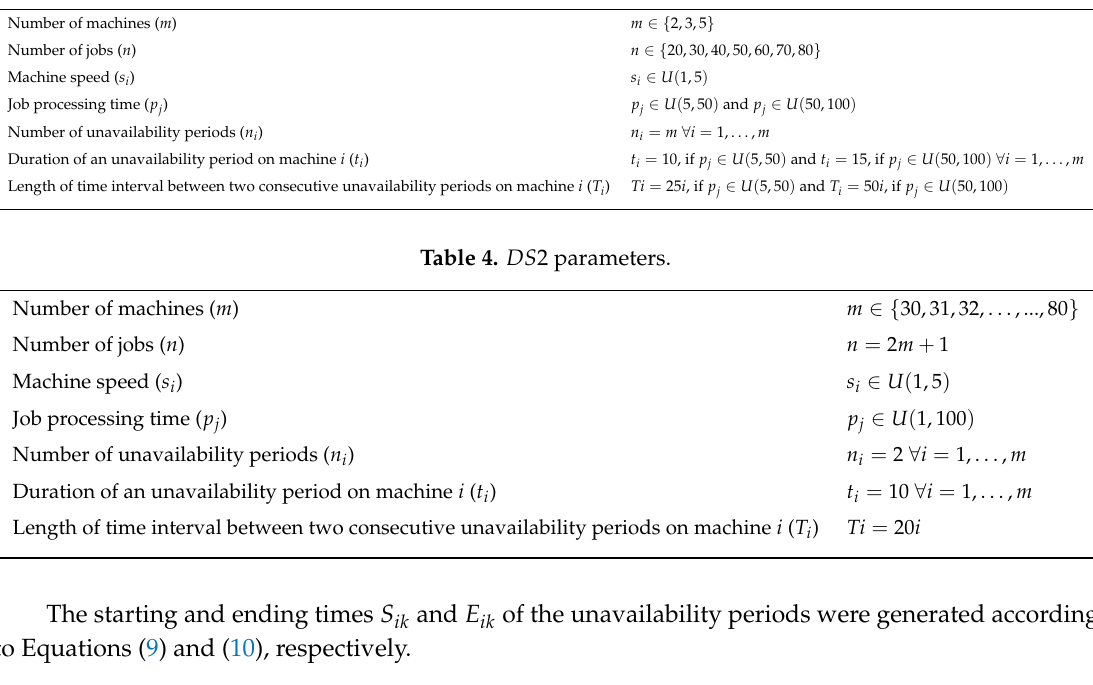
Table 3. DS 1 parameters.